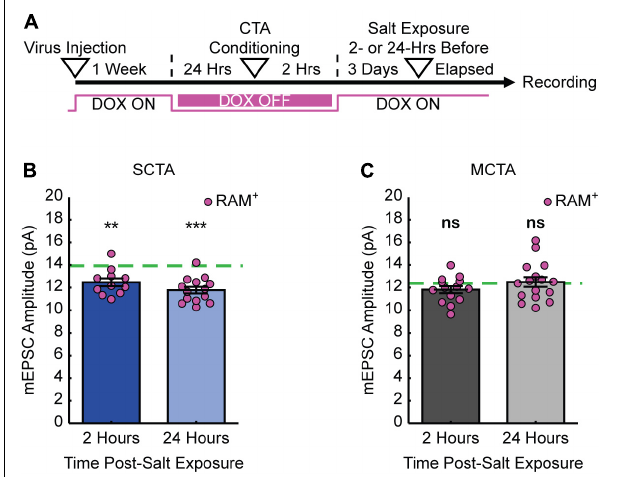
FIGURE 4 | Experience with salt rapidly reverses increases in postsynaptic strength. (A) Experimental design. (B) SCTA cell-average mEPSC amplitudes of RAM + cells 2- and 24-h post-salt exposure. Green dashed line represents average mEPSC amplitude from RAM + cells in SCTA no-salt exposure conditions ( Figure 3D ; one-sample t test against hypothesized mean, 2 h, p = 0.0018, 24 h, p = 5.5750e-06). (C) MCTA cell-average mEPSC amplitudes of RAM + cells 2- and 24-h post-salt exposure. Green dashed line represents average mEPSC amplitude from RAM + cells in MCTA no-salt exposure conditions ( Figure 3D ; one-sample t test against hypothesized mean, 2 h, p = 0.0857, 24 h, p =